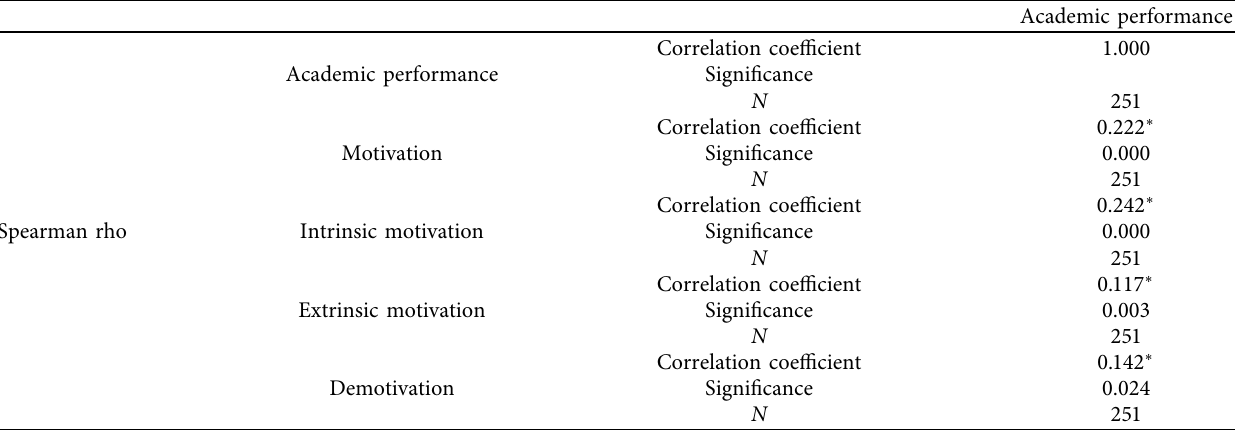
Table 7: Relationship between motivation, its dimensions, and academic performance.